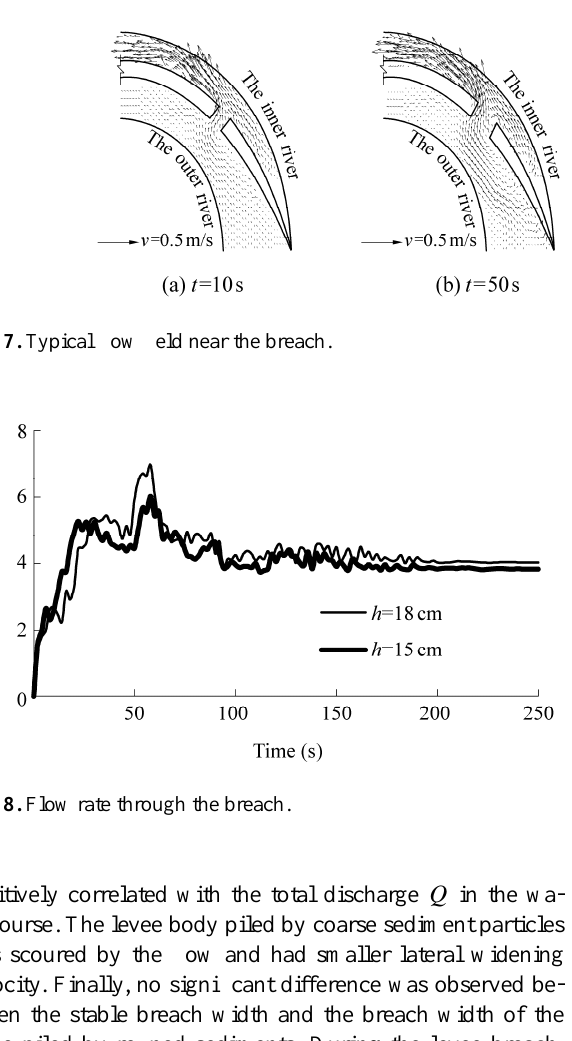
Fig. 6 Comparison between the calculated water level and actual water level.